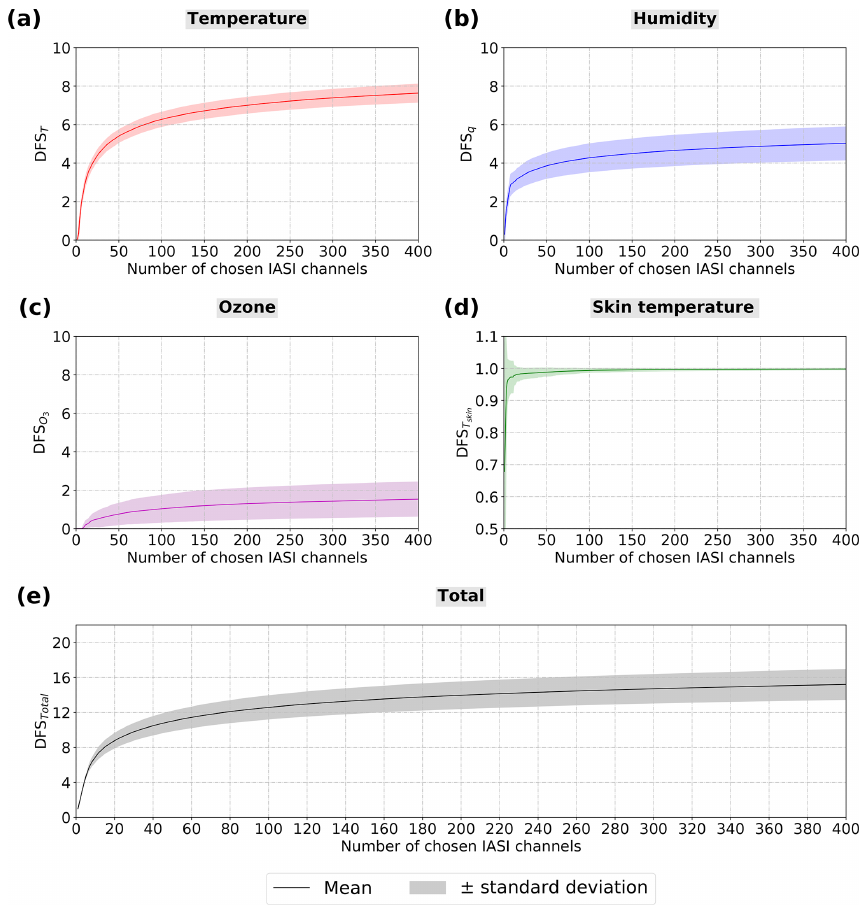
Figure 8. Evolution of the mean DFS plus and minus standard deviation for temperature (a) , humidity (b) , ozone (c) , skin temperature (d) and total (e) during the channel selection over the subset of 60 atmospheric